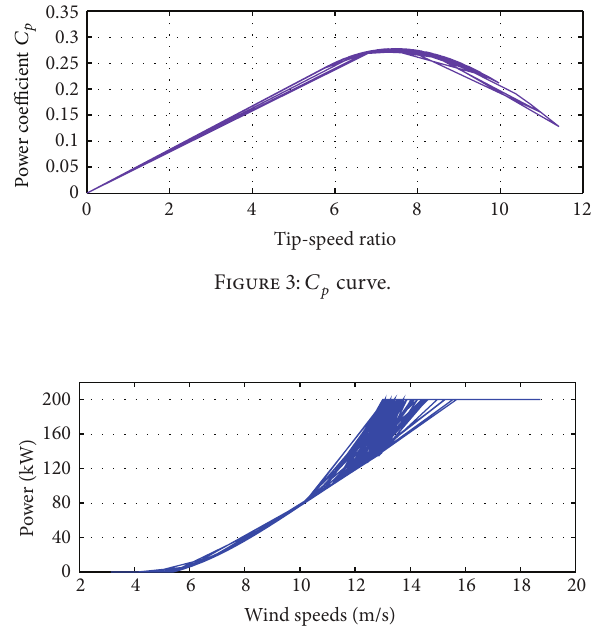
Figure 4: Wind turbine power curve.